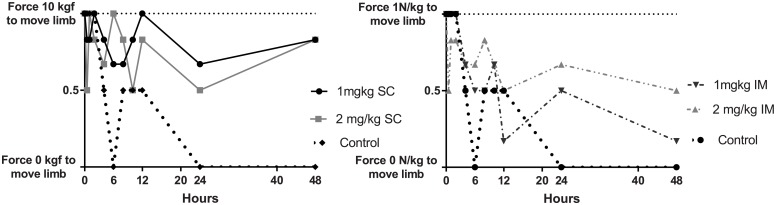
A. Limb sensitivity at selected time-points for control group and 1.0 and 2.0 mg/kg SC treatment groups B. 1.0 and 2.0 mg/kg IM treatment groups. Significant differences between all meloxicam treatments with the control group at 6 h (P < 0.05), at 12 h, the 1.0 mg/kg and 2.0 mg/kg IM treatment was significantly different the control group (P < 0.05), and at 48 h the 1 and 2 mg/kg SC treatments were significantly different to the control group (P < 0.05).